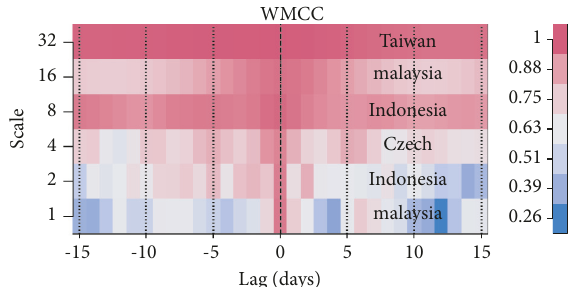
Figure 15: Wavelet multiple cross correlation between overall systematic risk of Emerging Markets (18/08/2010–03/11/2020). Table 3: Wavelet multiple cross correlations (WMCC). Scale